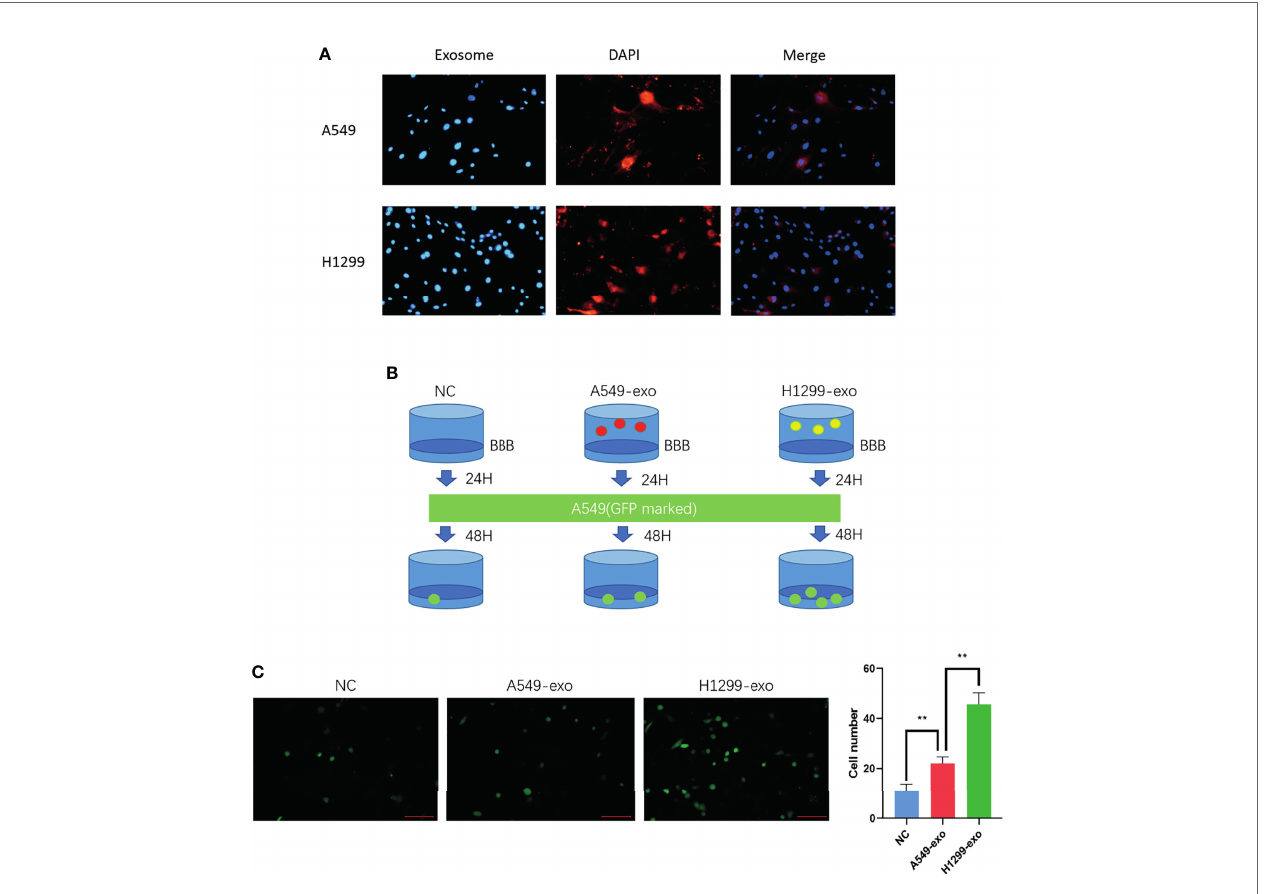
FIGURE 3 | The exosomes from a highly metastatic cell line can promote cancer cell invasion in an in vitro BBB model. (A) DiI dye tracing of exosomes from A549 and H1299 cells. BMECs internalized exosomes after 24 incubation. (B) Schematic diagram of the Transwell assay for cancer cell-derived exosomes promoting A549 cells to penetrate the BBB model. The in vitro BBB model was incubated with exosomes for 24 h, and then GFP-marked A549 cells were cultured for another 48 h. (C) Exosomes were added to the BBB in vitro model and incubated for 24 hours. Then, A549 cells were added, and the number of cells crossing was counted after 48 hours (magni fi cation ×200, one-way ANOVA, *P < 0.05, **P <